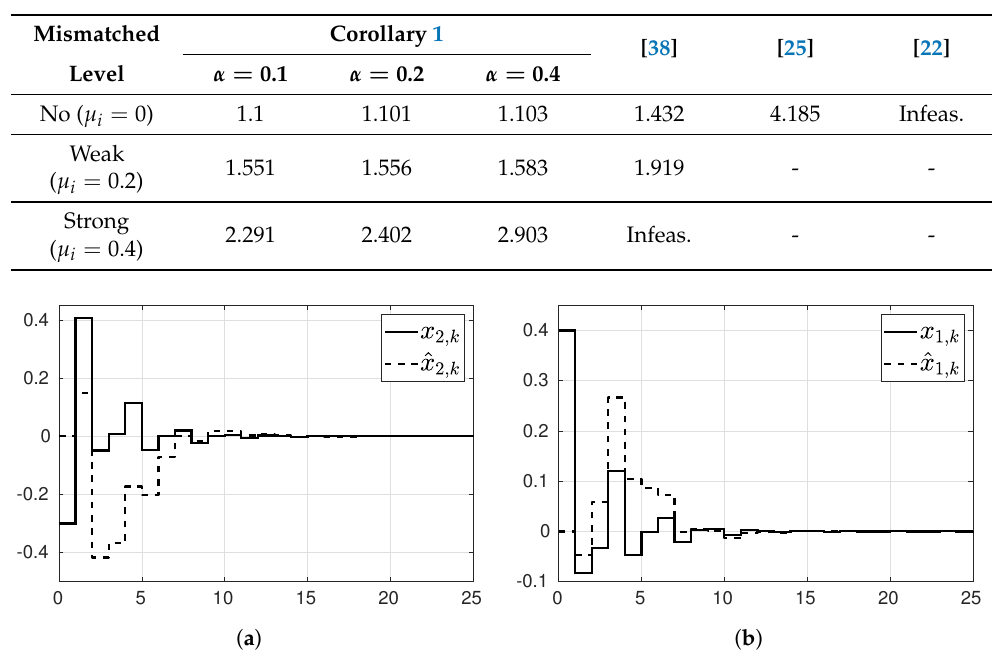
Table 1. Comparisons of H ∞ -indices of Example 1 ( a = − 1.6 and b = 0) with different mismatched levels.